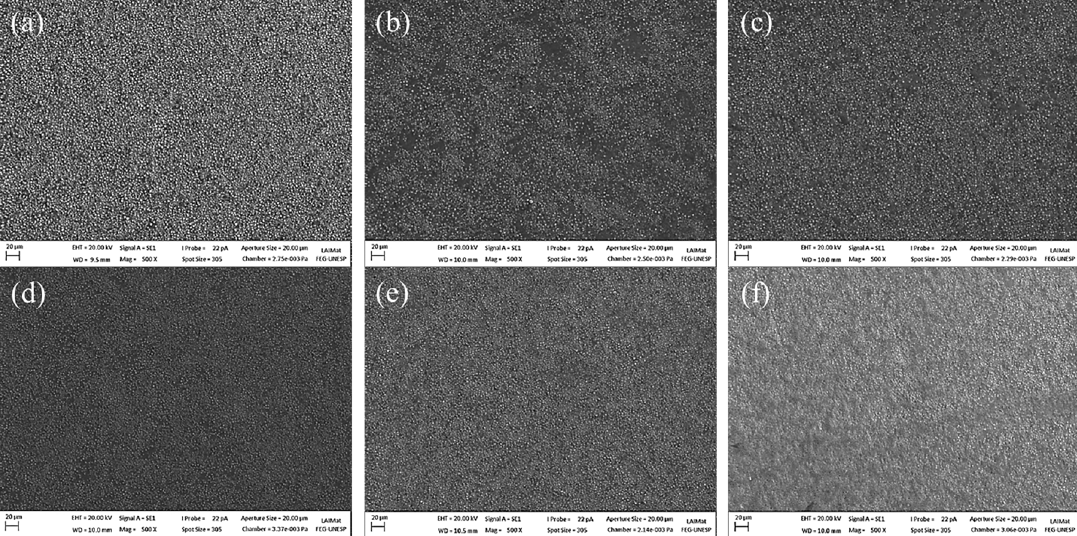
Figure 4. SEM images obtained using a secondary electron detector for mechanically polished titanium substrates (MP) after anodization at different anodization times: 3 h (a, d), 6 h (b, e), 12 h (c, f); and two electrolyte concentrations (H 2.5